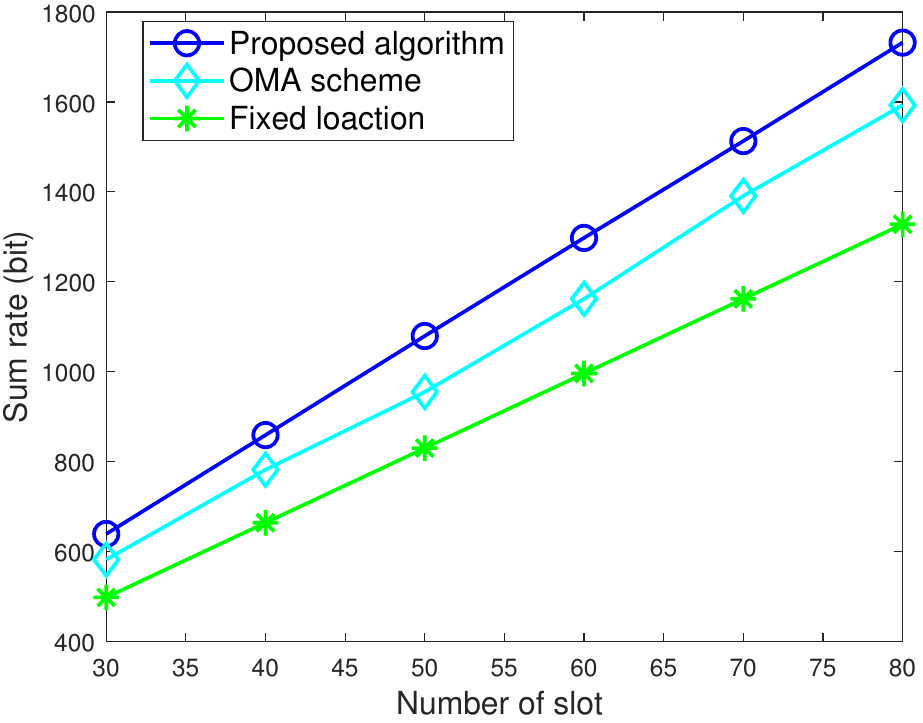
Figure 4. The sum rate w.r.t. the number of